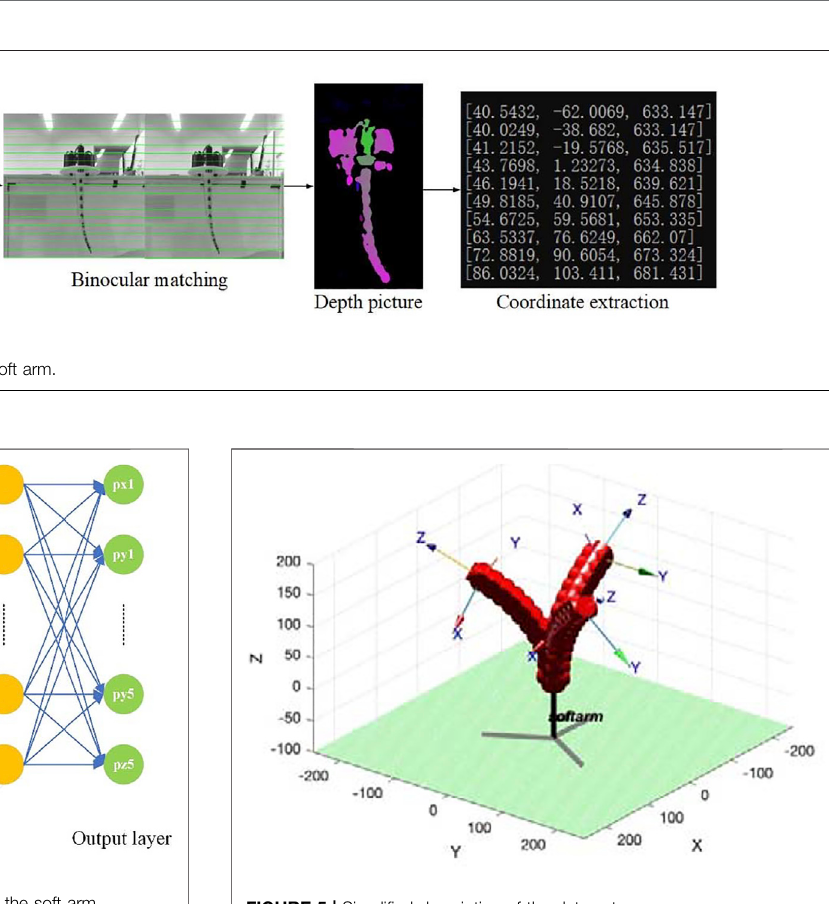
FIGURE 4 | Structure design of the neural network of the soft arm. FIGURE 5 | Simpli fi ed description of the data